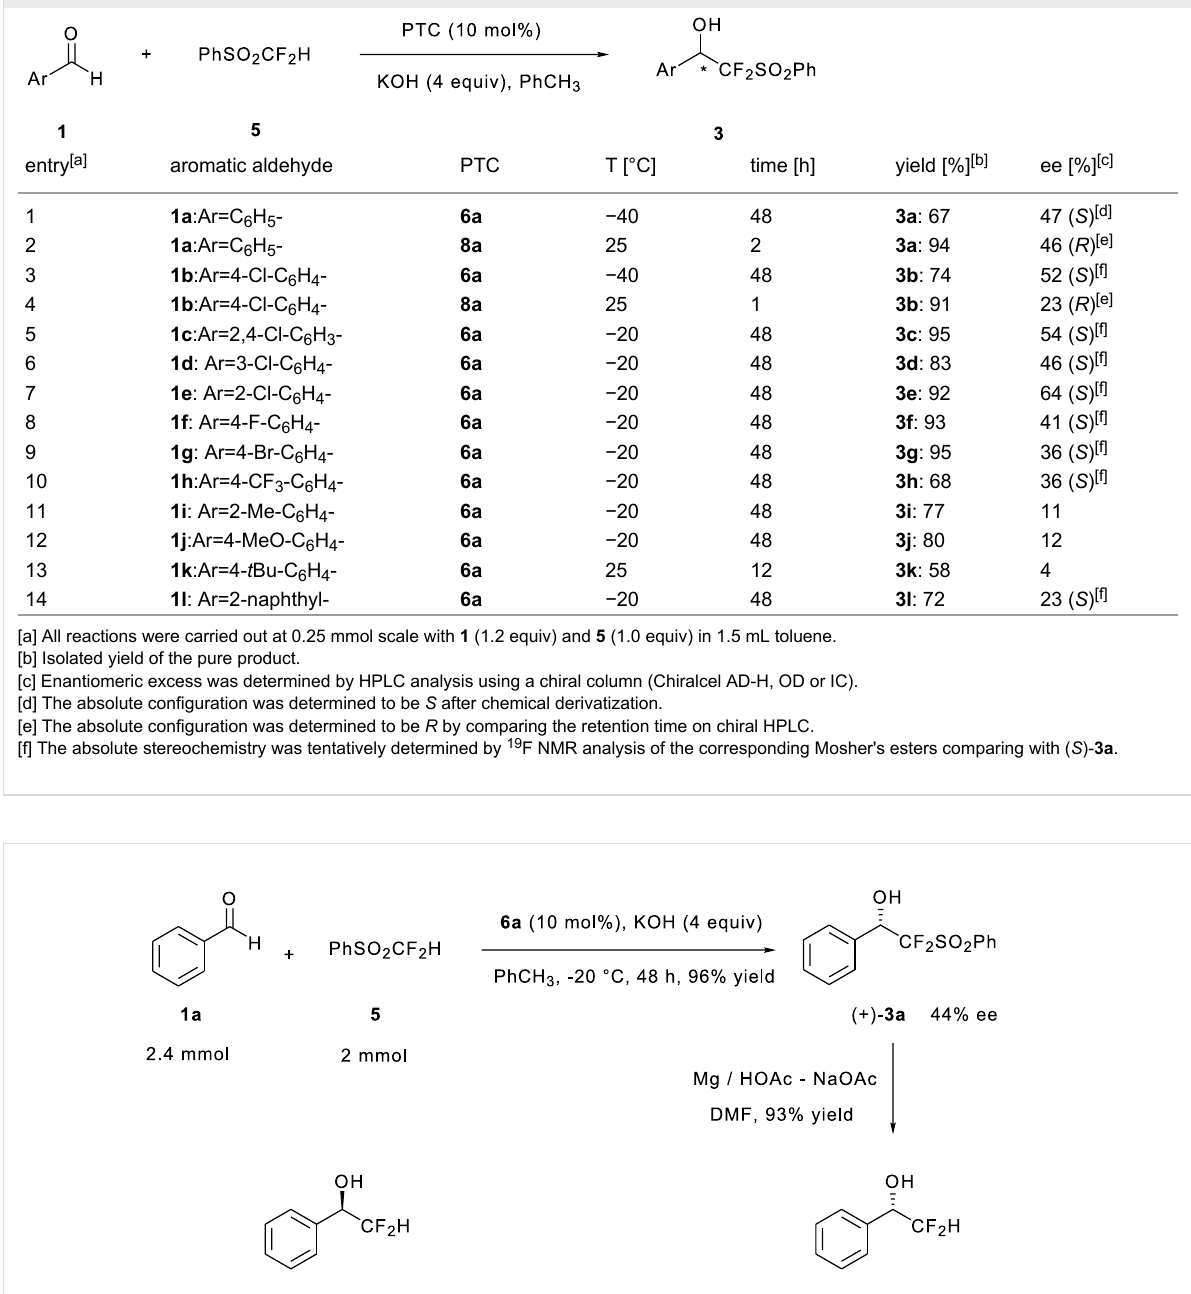
Table 3: Asymmetric nucleophilic difluoromethylation of aromatic aldehydes with PhSO 2 CF 2 H.